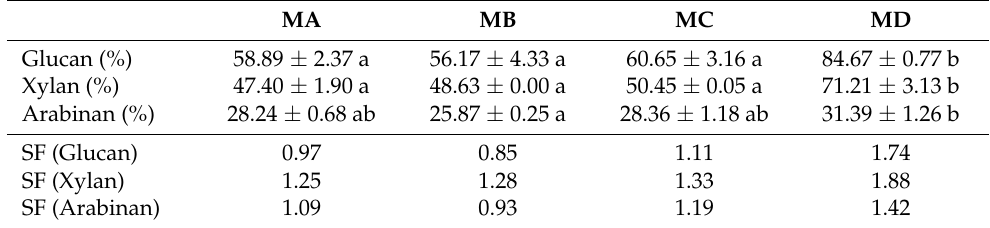
Table 4. Saccharification of the CRM fractions using the enzyme extract mixtures and a solid–liquid ratio of 1:60 ( w / v